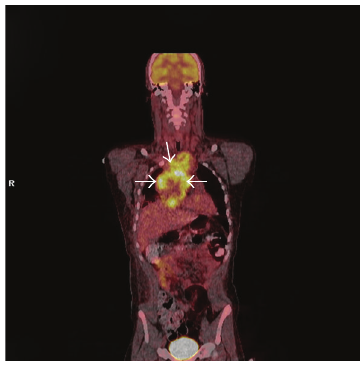
Figure 3: Positron emission tomography (PET) scan showing a hypermetabolic mediastinal mass (see arrows).